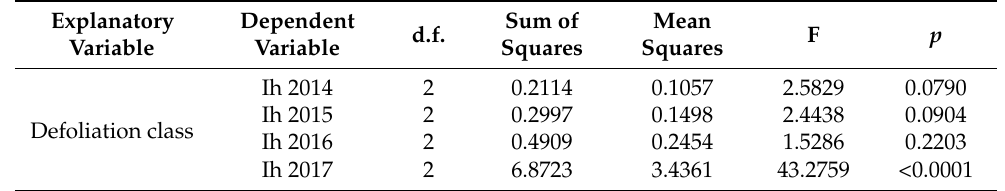
Table 1. Summary statistics for differences between annual height growths depending on the defoliation class (repeated measures ANOVA).